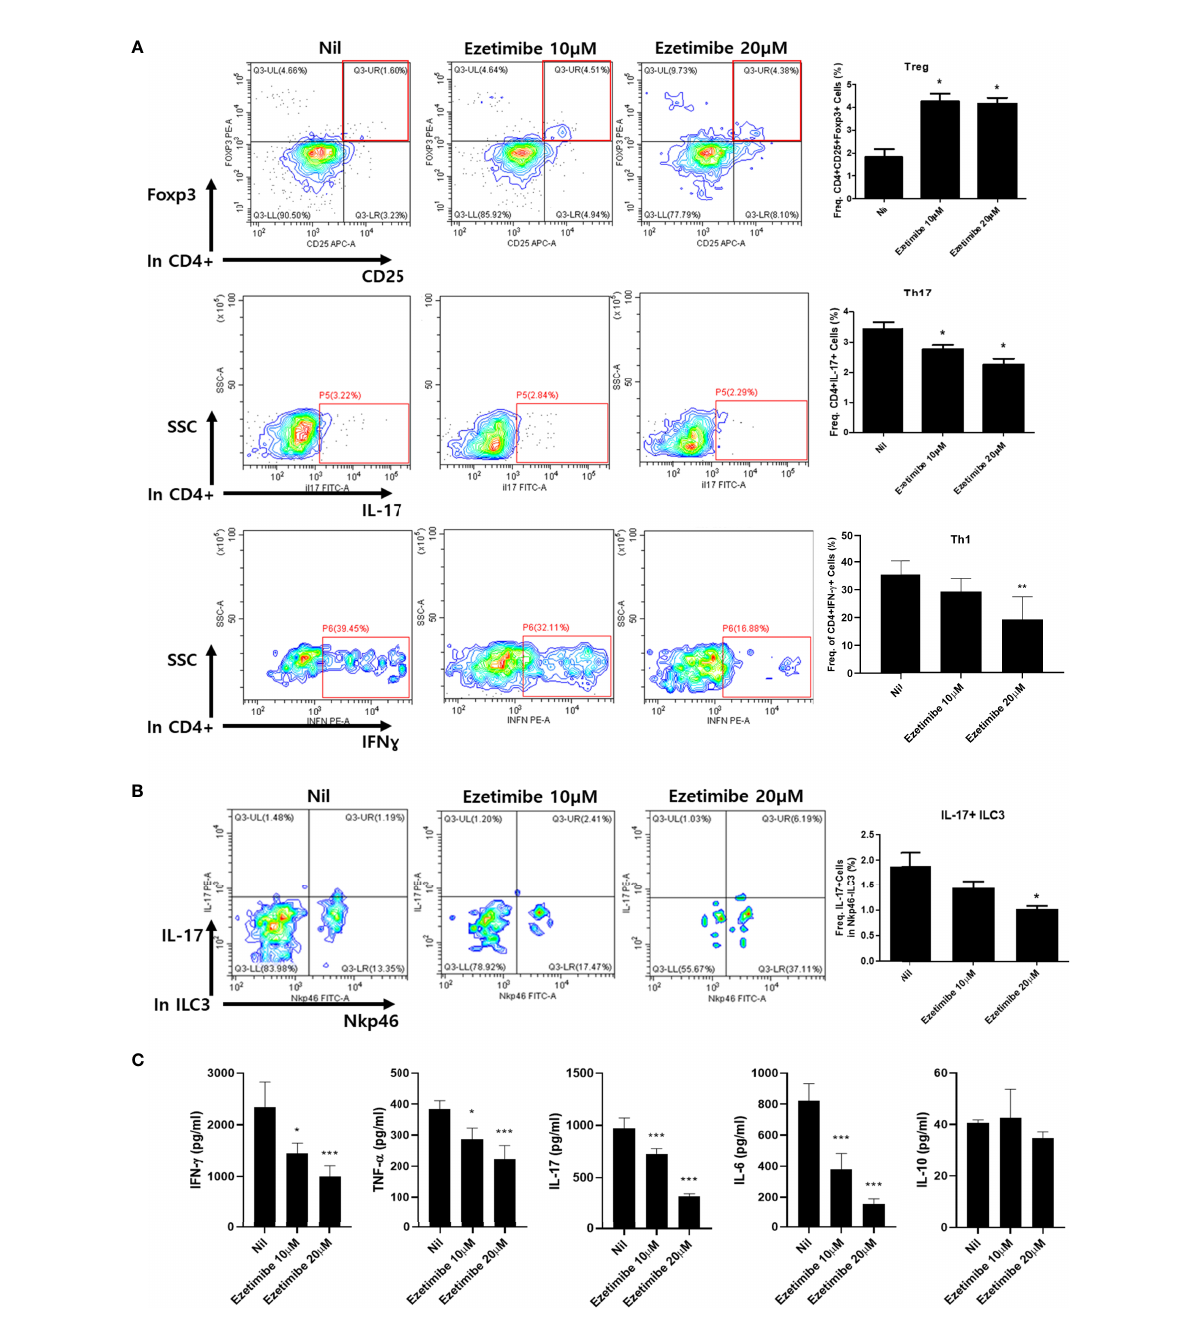
FIGURE 3 Effects of ezetimibe on mouse splenocytes in vitro . (A) The populations of Treg, Th17 and Th1 cells were analyzed by fl ow cytometry. (B) IL-17- producing ILC3 population. (C) The concentrations of IFN- g , TNF- a , IL-17, IL-6 and IL-10 were measured by ELISA in culture supernatants. Values are means ± SEMs of three independent experiments. *p < 0.05, **p < 0.01, ***p <